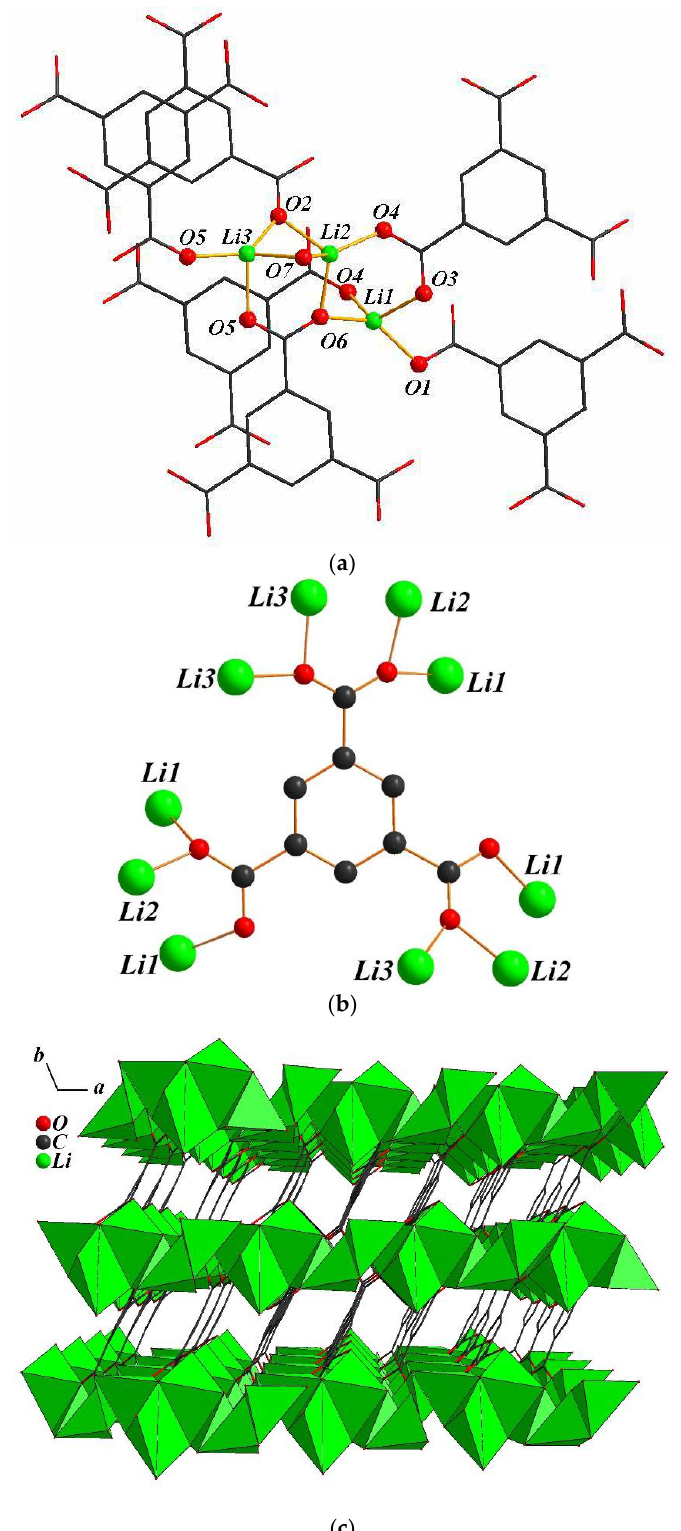
Figure 3. ( a ) The coordination spheres of lithium atoms in 3 ; ( b ) the coordination model of the BTC ligand in 3 ; ( c ) the 3-D network viewed along the c -axis with edge-sharing 1-D chains in compound 3 (H atoms were omitted for clarity).